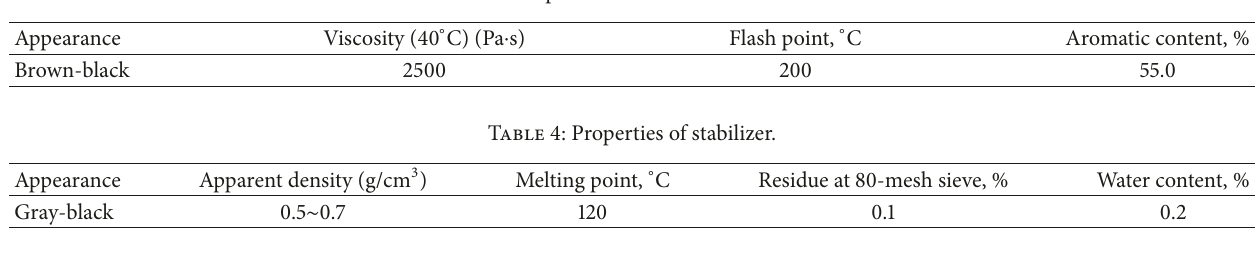
Table 3: Properties of furfural extraction oil.